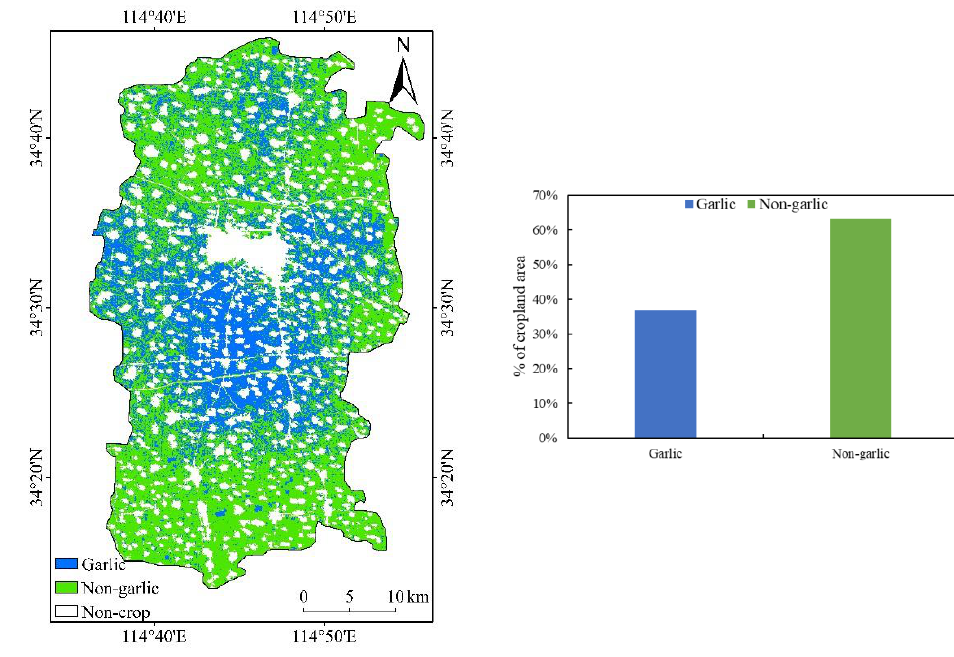
Figure 6. Early-season garlic distribution map.